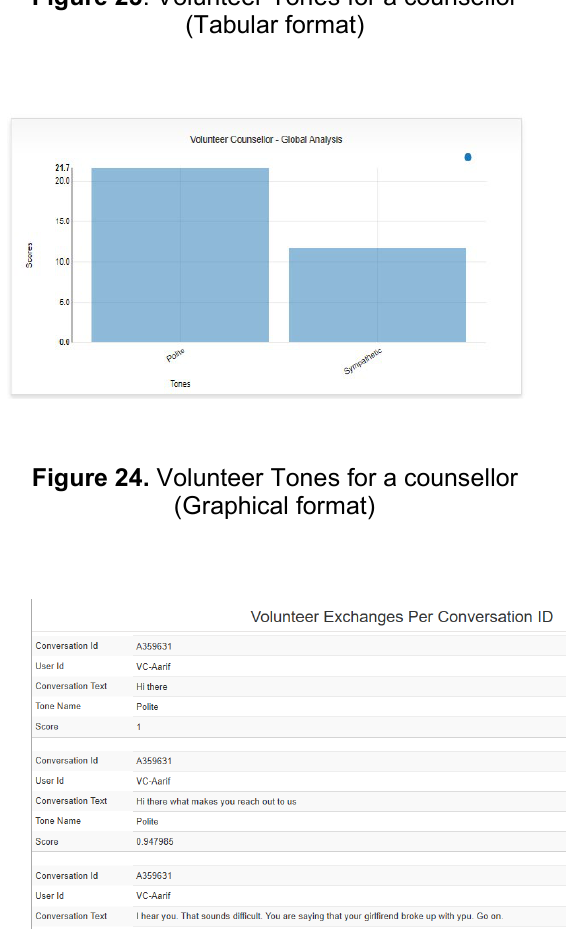
Figure 23 . Volunteer Tones for a counsellor